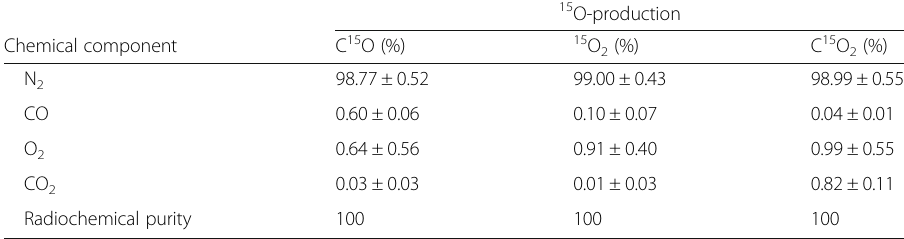
Table 2 Chemical concentration and radiochemical purity